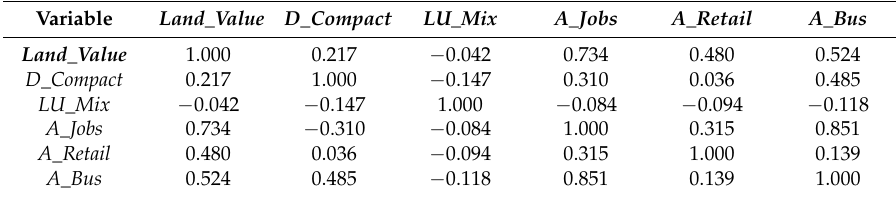
Table 3. Correlation coefficients between variables ( N =